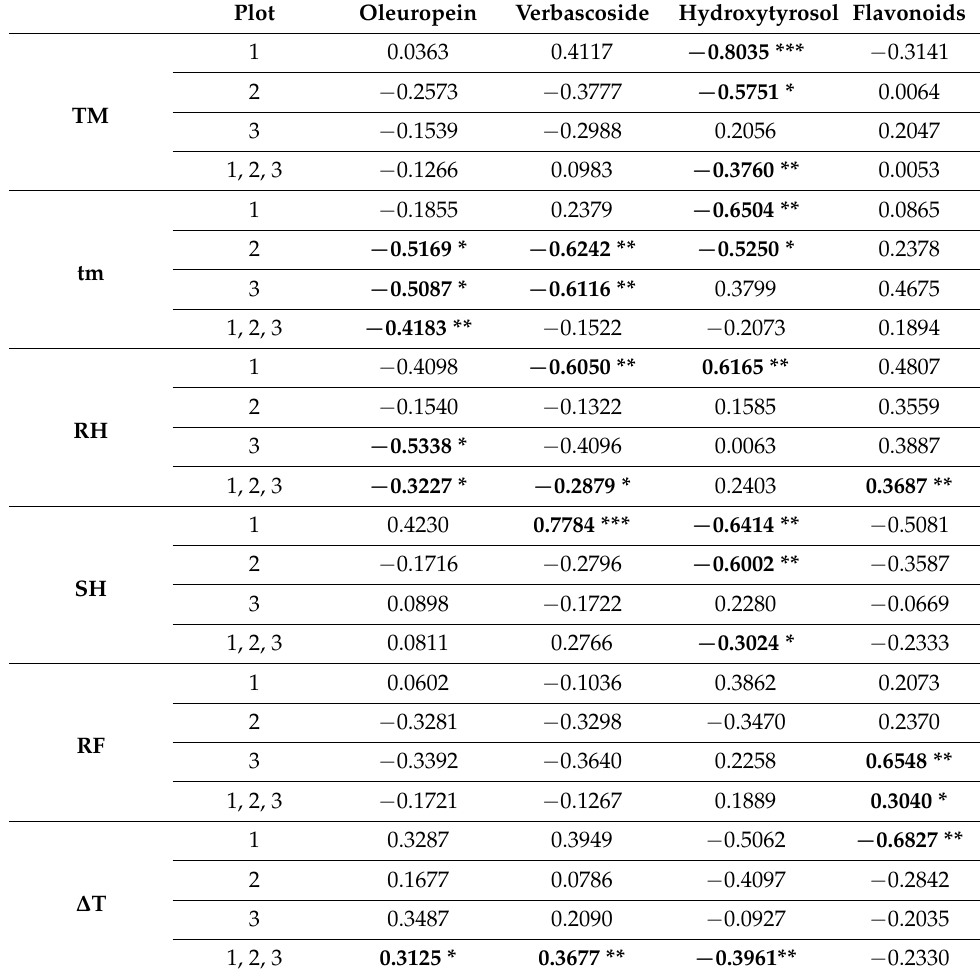
Table 4. Correlation between the different climatic conditions and compounds of olive